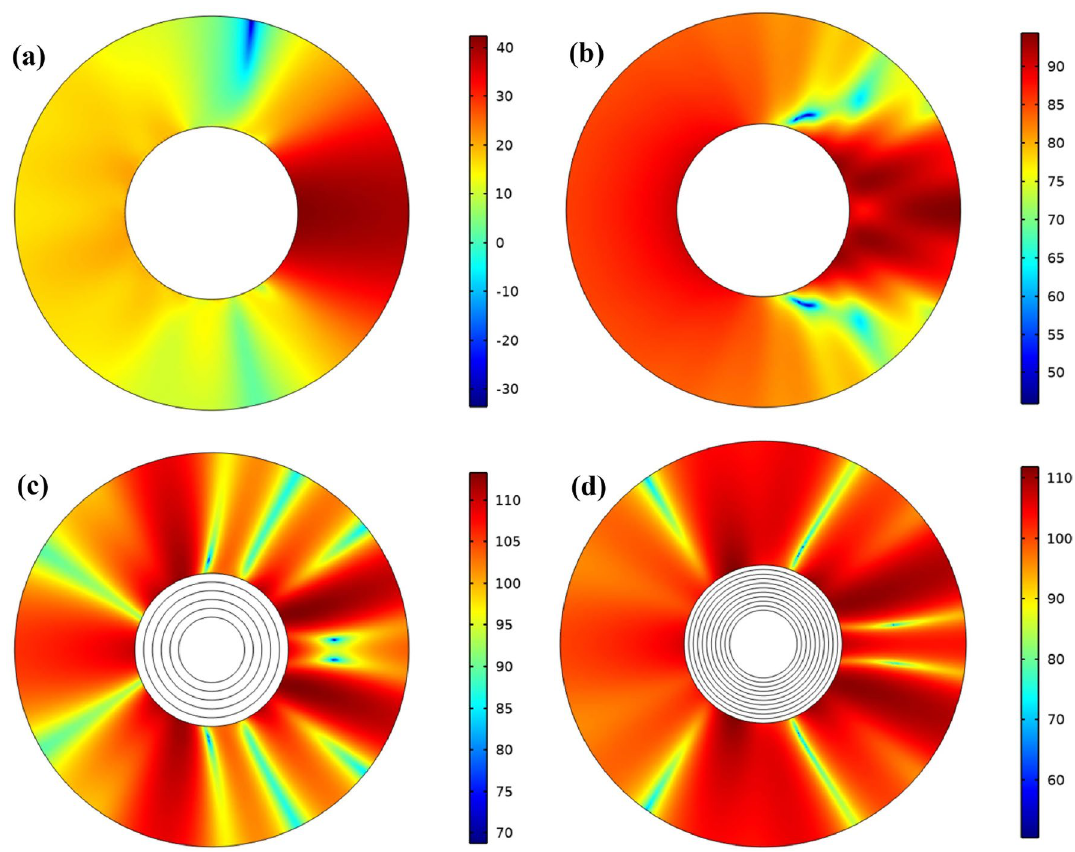
Figure 4. The scattering pressure level for ( a ) homogeneous cloak, ( b ) no cloak structure and multi-layers cloaking with ( c ) 5 layer and ( d ) 10 layers.